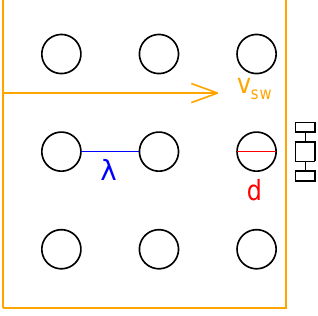
Figure 1. Schematic of a number of structures with a mean sepa- ration λ and diameter d (or thickness) of the structures. These are being advected over the spacecraft with the solar wind bulk velocity.